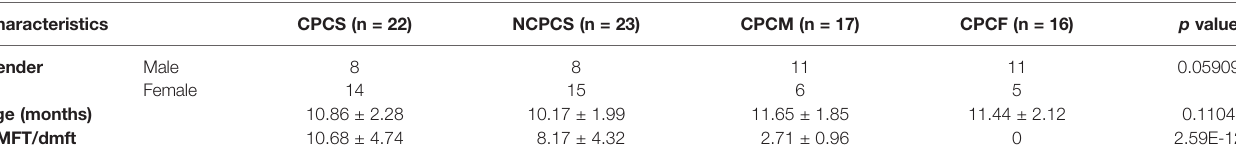
TABLE 1 | Participant characteristics in current